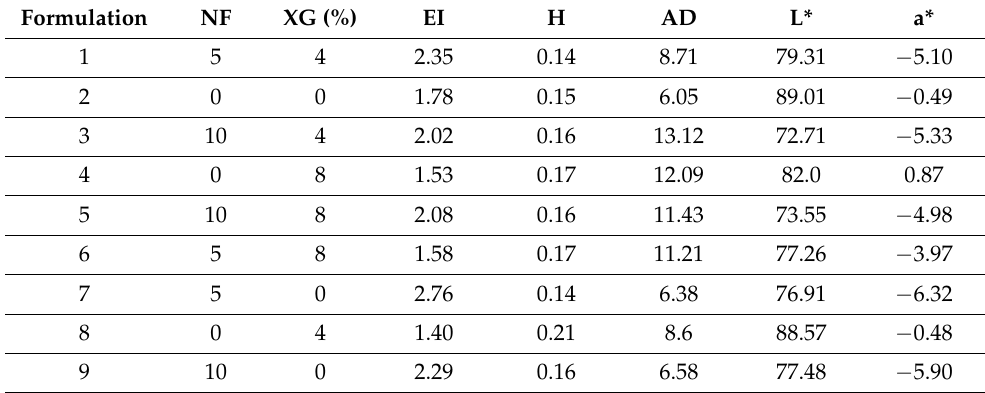
Figure 5. Effect of fiber and rubber interaction in EI in snacks made from ( a ) native rice starch, and ( b ) modified starch. Table 7. Results of the analysis of snacks made from modified